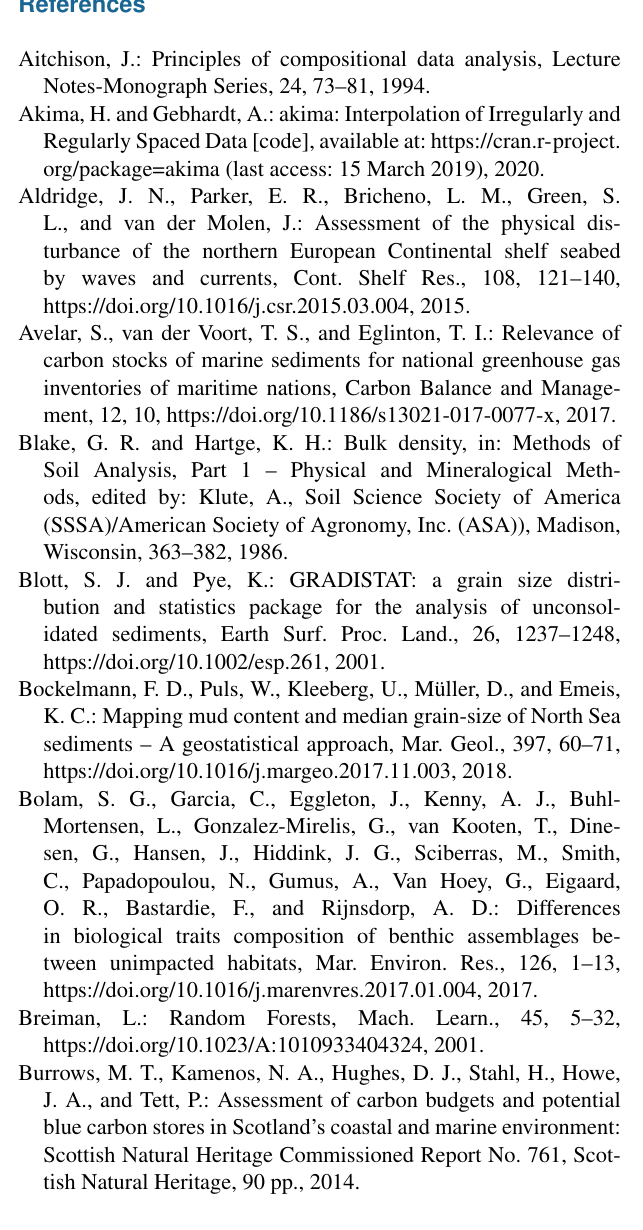
Figure A1. Relationship between (a) the mass fraction of organic carbon in mud (gCg − 1 mud) and in sand (gCg − 1 sand) and (b) the mass fraction of organic nitrogen in mud (gNg − 1 mud) and in sand (gNg − 1 sand) for sediment collected from the North Sea by CE- FAS and the Clyde